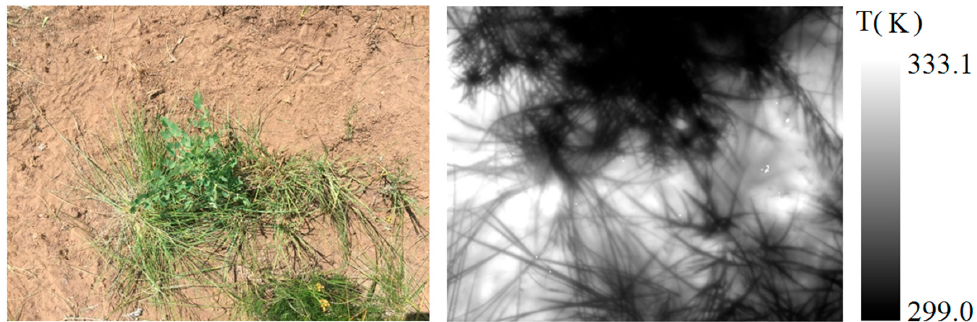
Figure 15. Temperature of Artemisia subulata Nakai retrieved from thee HTIR dataset.